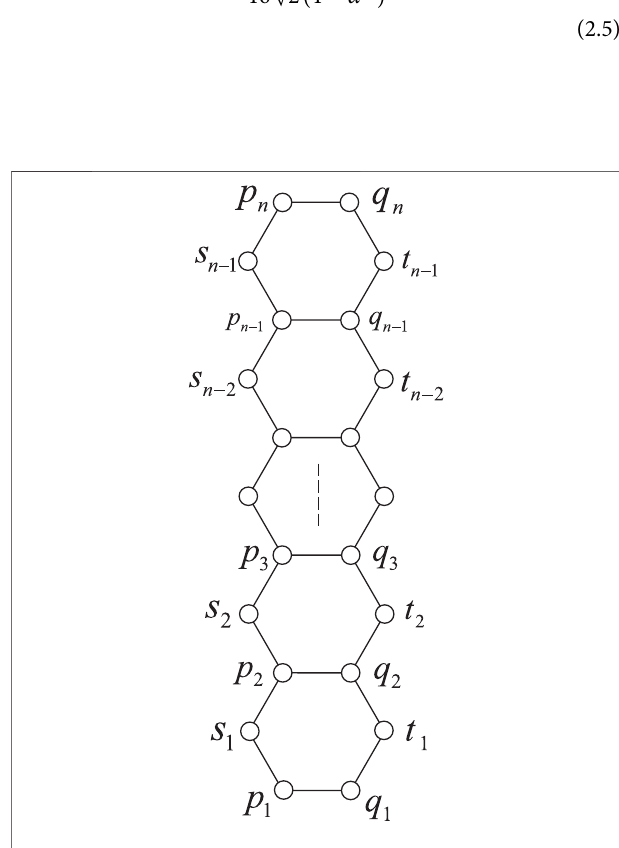
FIGURE 1 | Linear polyacne graph L n and its vertex